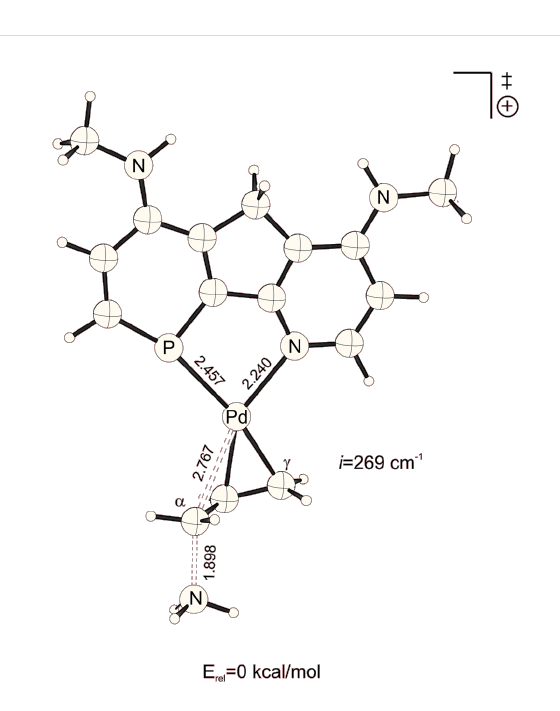
Figure 4: Transition structure for the energetically favored cis to phos- phorus addition of ammonia at the Pd-η 3 -allylic intermediate (B3LYP/6- 31G* (C, H, N, P, O), /SDD (Pd)). Bond distances are given in Å.